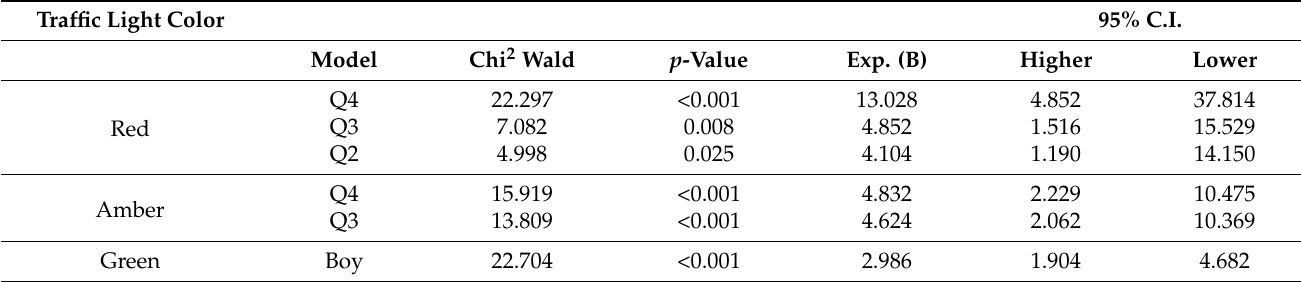
Table 5. Regression models based on the quarter of birth and gender